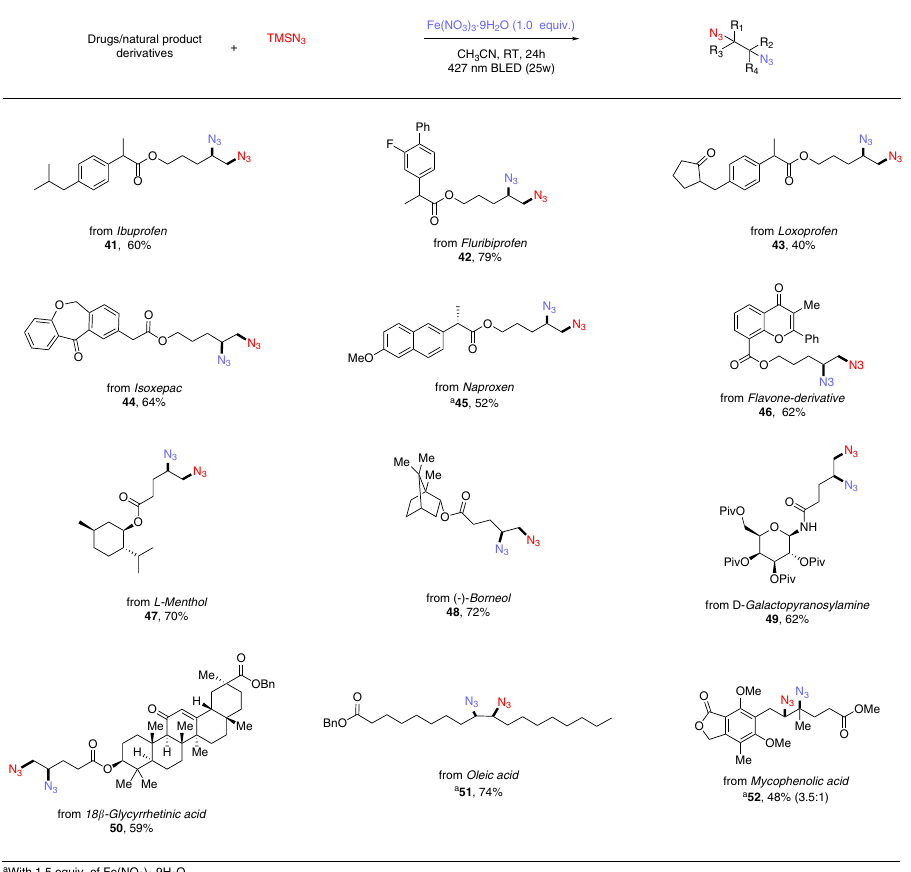
Fig. 3 | Scope of diazidation of drugs/natural product-derived alkenes (batch reactions). Reaction conditions: alkenes (0.1mmol, 1 equiv.), TMSN 3 (4 equiv.),